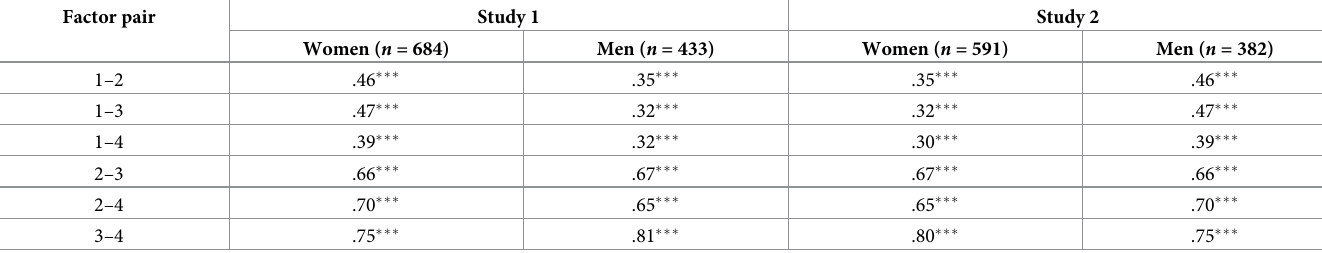
Table 4. Factor covariances in Parker et al.’s model of the eating disorder examination questionnaire [44] in women and men.